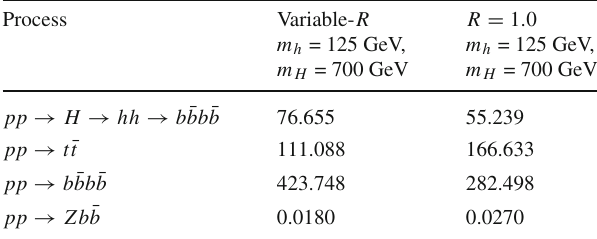
Table 8 Upper panel: final (cid:16) values calculated upon enforcing the initial cuts plus the mass selection criteria of Fig. 8 for the two jet reconstruction procedures. Lower panel: the same in presence of K